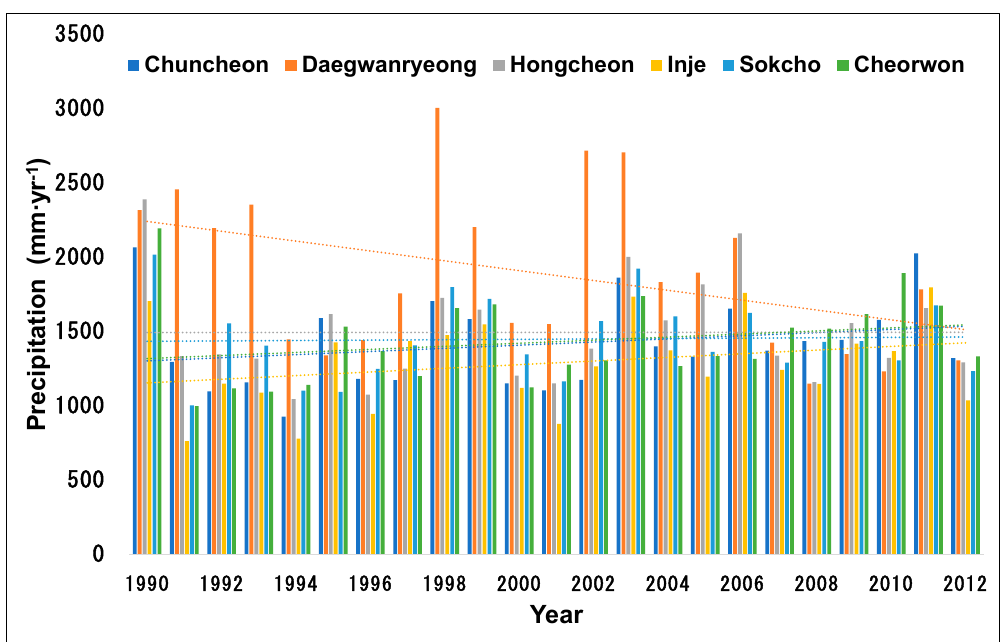
Figure 2. Annual precipitation at six weather stations (1990–2012).